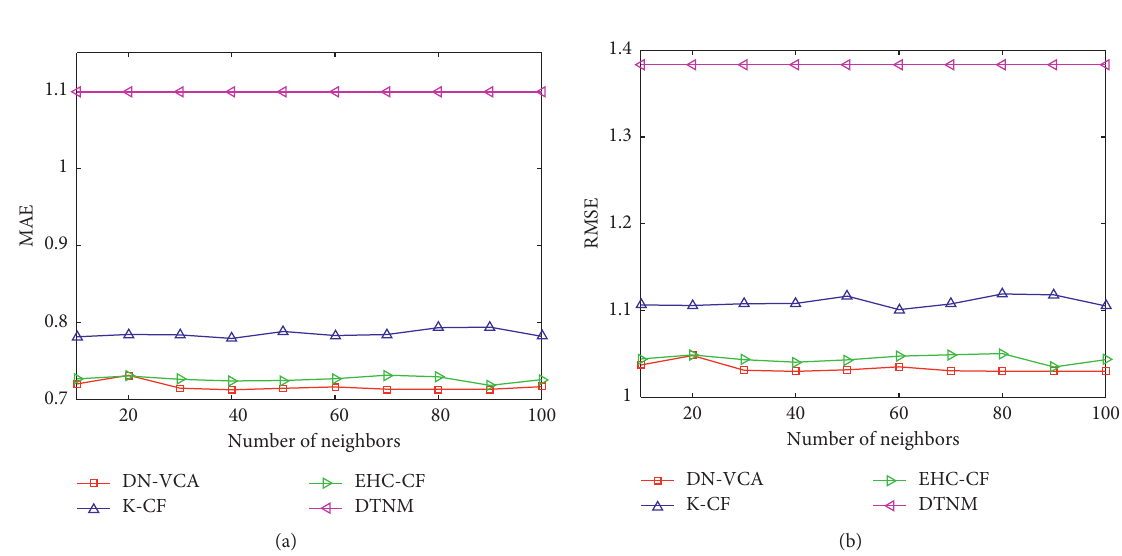
Figure 10: CiaoDVD-1. (a) Comparison results of MAE of four algorithms. (b) Comparison results of RMSE of four algorithms. Table 4: Precision, recall, and F